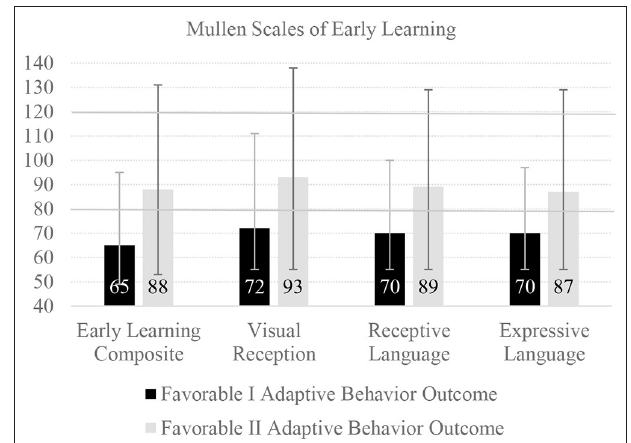
FIGURE 2 | One-year neuropsychological outcome following cardiac arrest in young children. There were 119 children in this study with outcome data at one-year post cardiac arrest (median age = 1.6, interquartile range = 1.2–3.1), with parent-rated mean pre cardiac arrest adaptive behavior composite scores of 95.2 (SD = 14.2) ( 30). There were 24 children in the Favorable I group who had adaptive behavior composite scores between 70 and 84, and 55 in the Favorable II group who had adaptive behavior composite scores of 85 or greater. The bars represent mean scores and the error lines represent the range of scores. The Mullen Scales are presented with a normative mean of 100 and a standard deviation of 15, so 90% of children in the normative sample would be expected to obtain scores between 80 and 120, demarcated with a solid horizontal line. The Early Learning Composite is an overall measure of functioning. The Visual Reception composite measures the ability to understand symbols and pictures, and spatial recognition of objects. This figure uses means and ranges presented in Slomine et al.